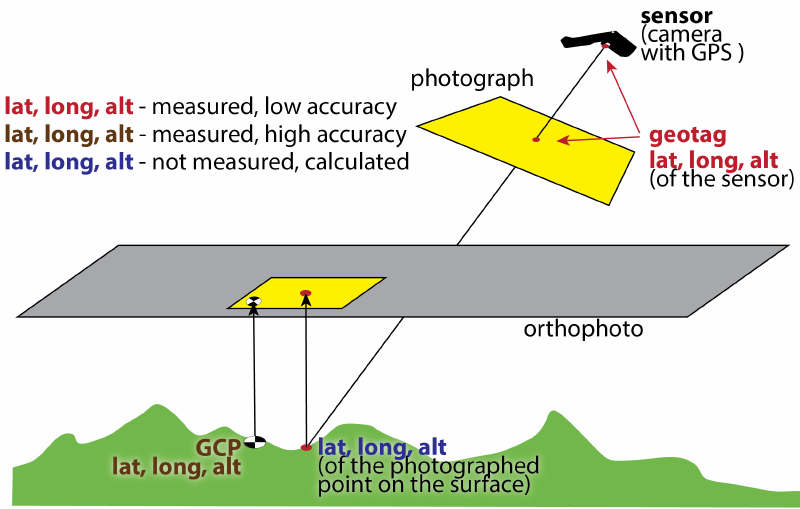
Figure 12. Comparison of georeferencing based on GCPs and imagery